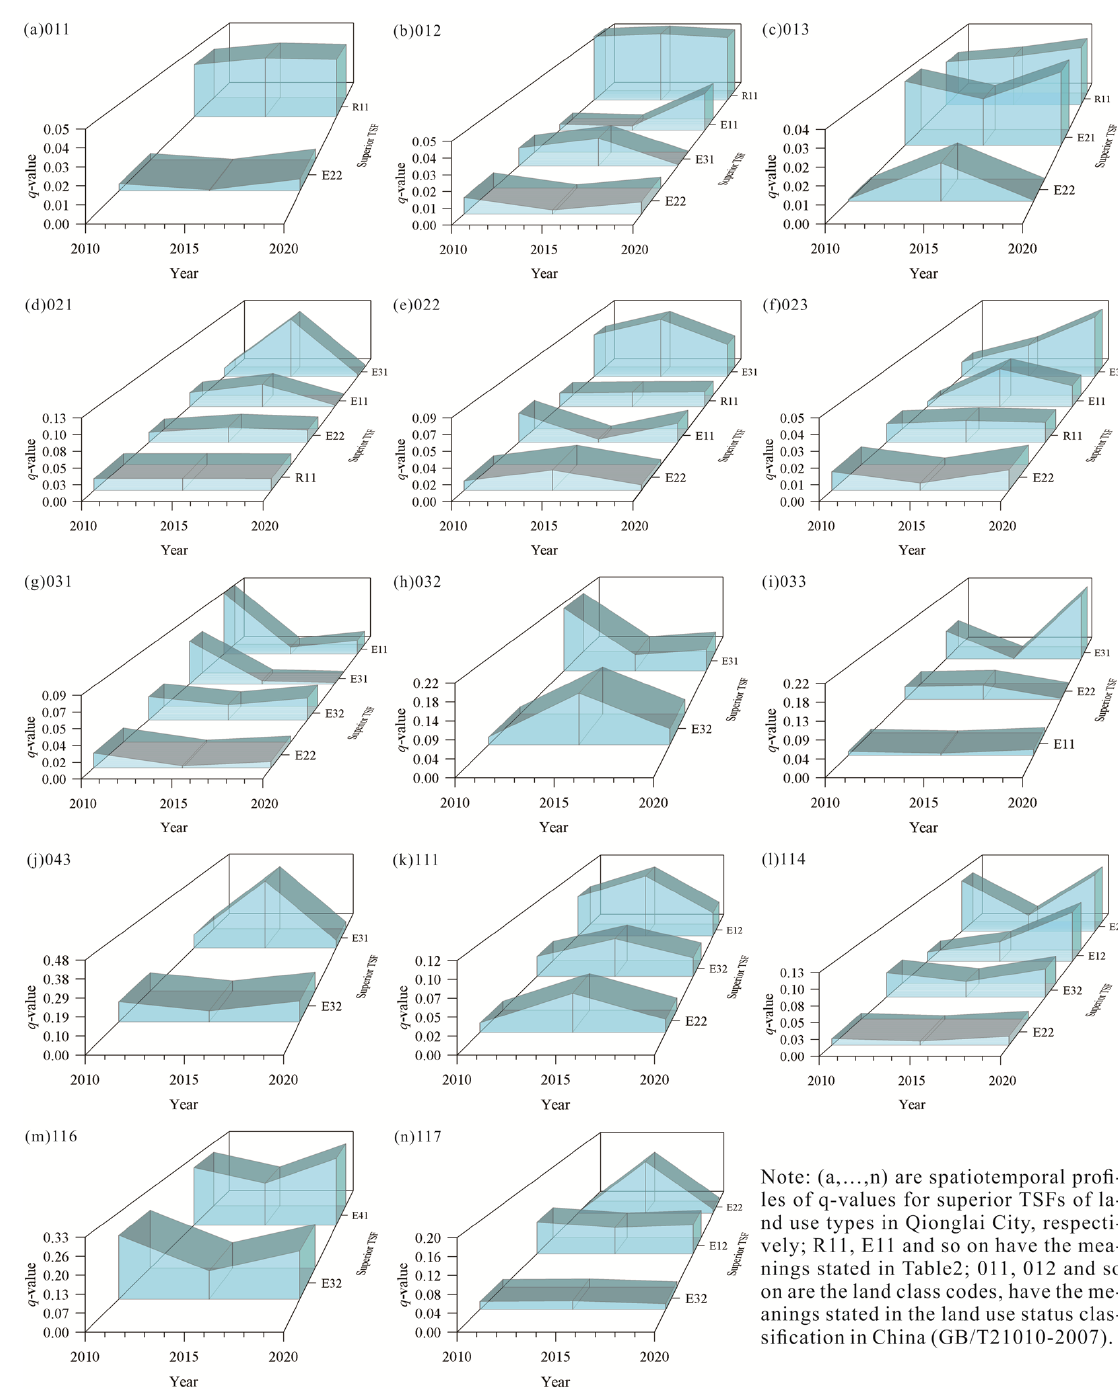
Figure 4. Spatiotemporal profiles of 𝑞 -values for superior TSFs of land use types in Qionglai City during 2010–2020.